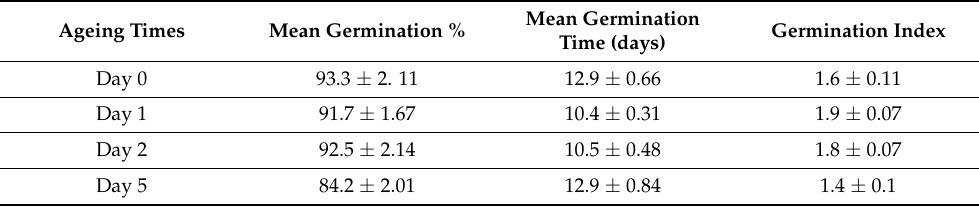
Table 1. Mean germination %, mean germination time (days) and germination index ( ± standard error) of artificially aged seeds of Navua sedge removed at various ageing